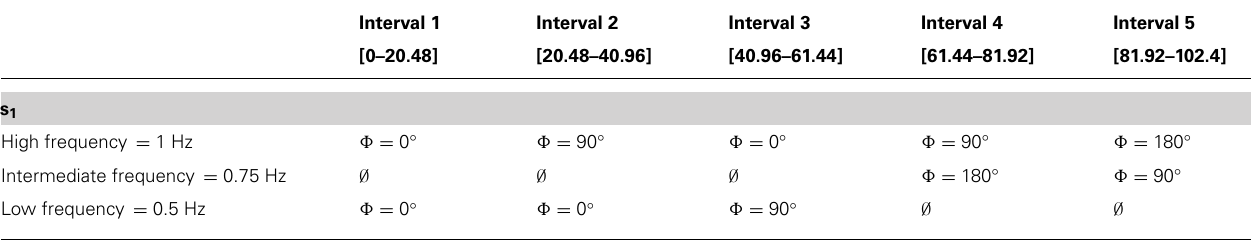
Table 1 | Details of the phase lag and frequency modulations of s 1